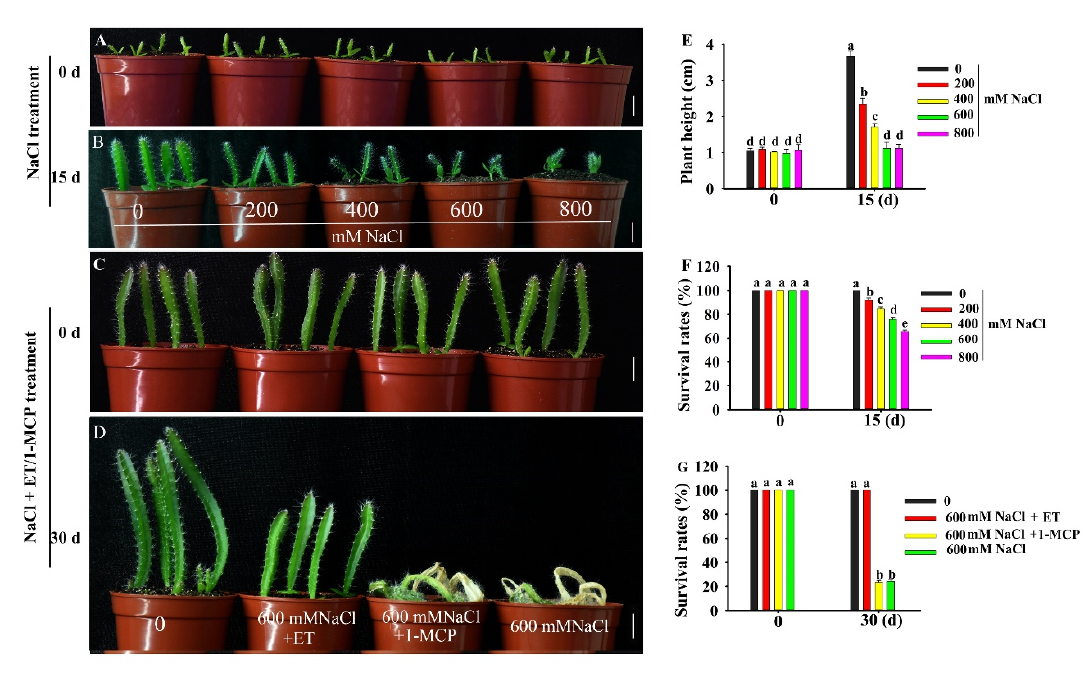
Figure 2. Phenotype of pitaya seedlings under salt, ET (ethephon) and 1-MCP (1-methylcyclopropene) treatments. ( A , B , E , F ) Phenotype ( A , B ), plant height ( E ) and survival rate ( F ) of two-week-old pitaya seedlings treated with di ff erent concentrations of NaCl for 15 days. ( C , D , G ) Phenotype ( C , D ) and survival rate ( G ) of six-week-old pitaya seedlings treated with 600 mM NaCl as well as 100 µ M ET or 100 µ M 1-MCP for 30 days. Data are presented as the mean ± SE ( n = 3). Di ff erent letters ( E – G ) indicate a significant di ff erence from that of the control at p < 0.05, ANOVA followed by Fisher’s LSD test. Bars = 1.5 cm.